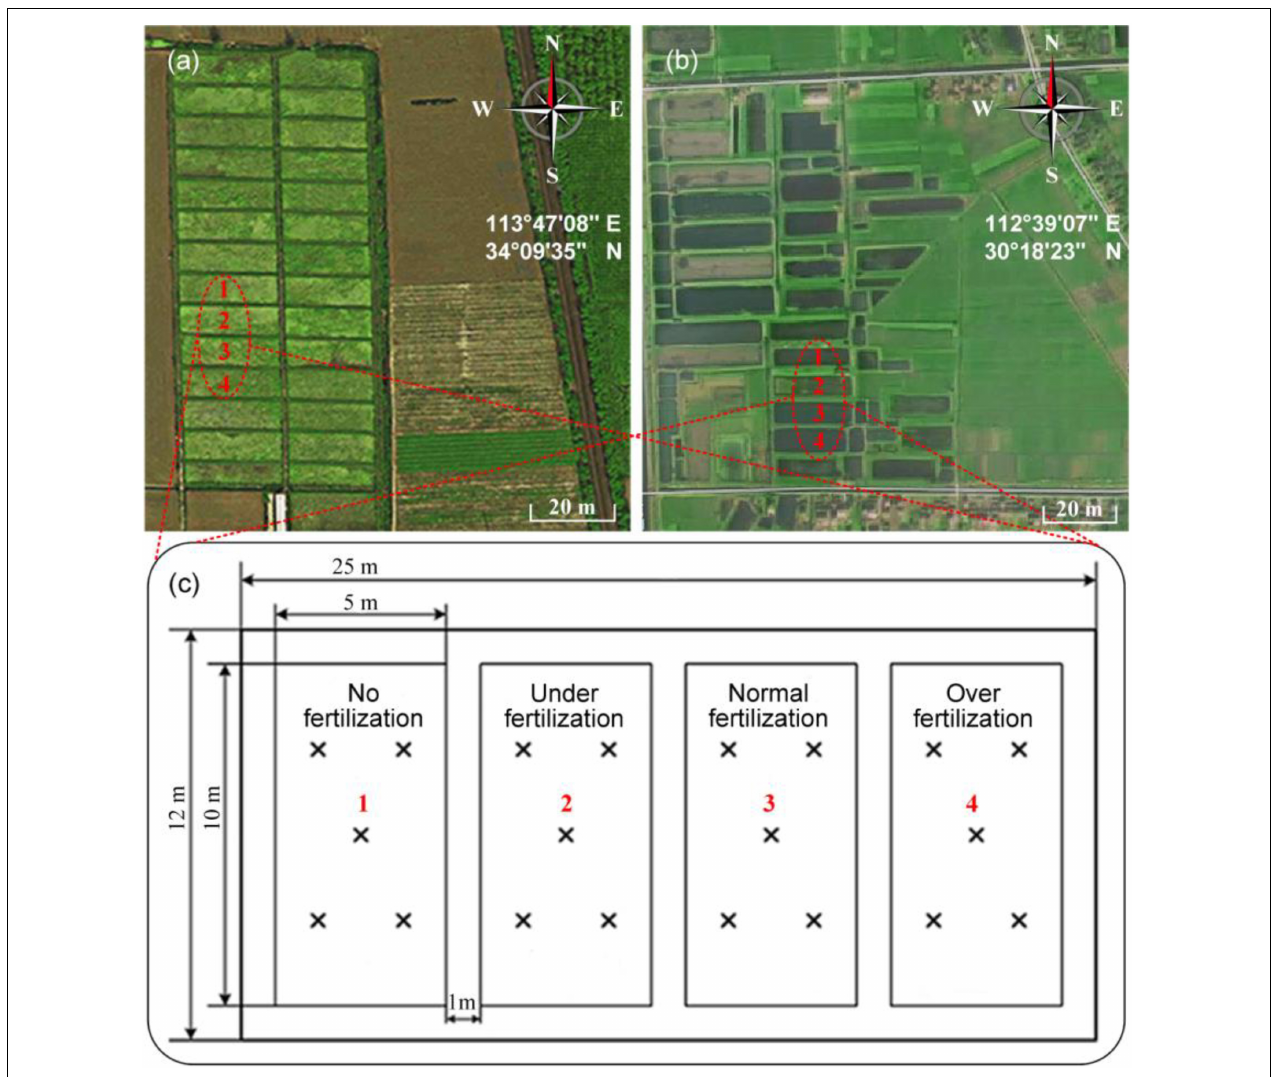
FIGURE 1 | Field experiment. The selected experiment place in (a) Xuchang (113 ◦ 47 (cid:48) 08 (cid:48)(cid:48) E, 34 ◦ 09 (cid:48) 35 (cid:48)(cid:48) N) and (b) Qianjiang (112 ◦ 39 (cid:48) 07 (cid:48)(cid:48) E, 30 ◦ 18 (cid:48) 23 (cid:48)(cid:48) N). (c) Field fertilization modes in the experiment place and “ × ” indicates the soil sampling